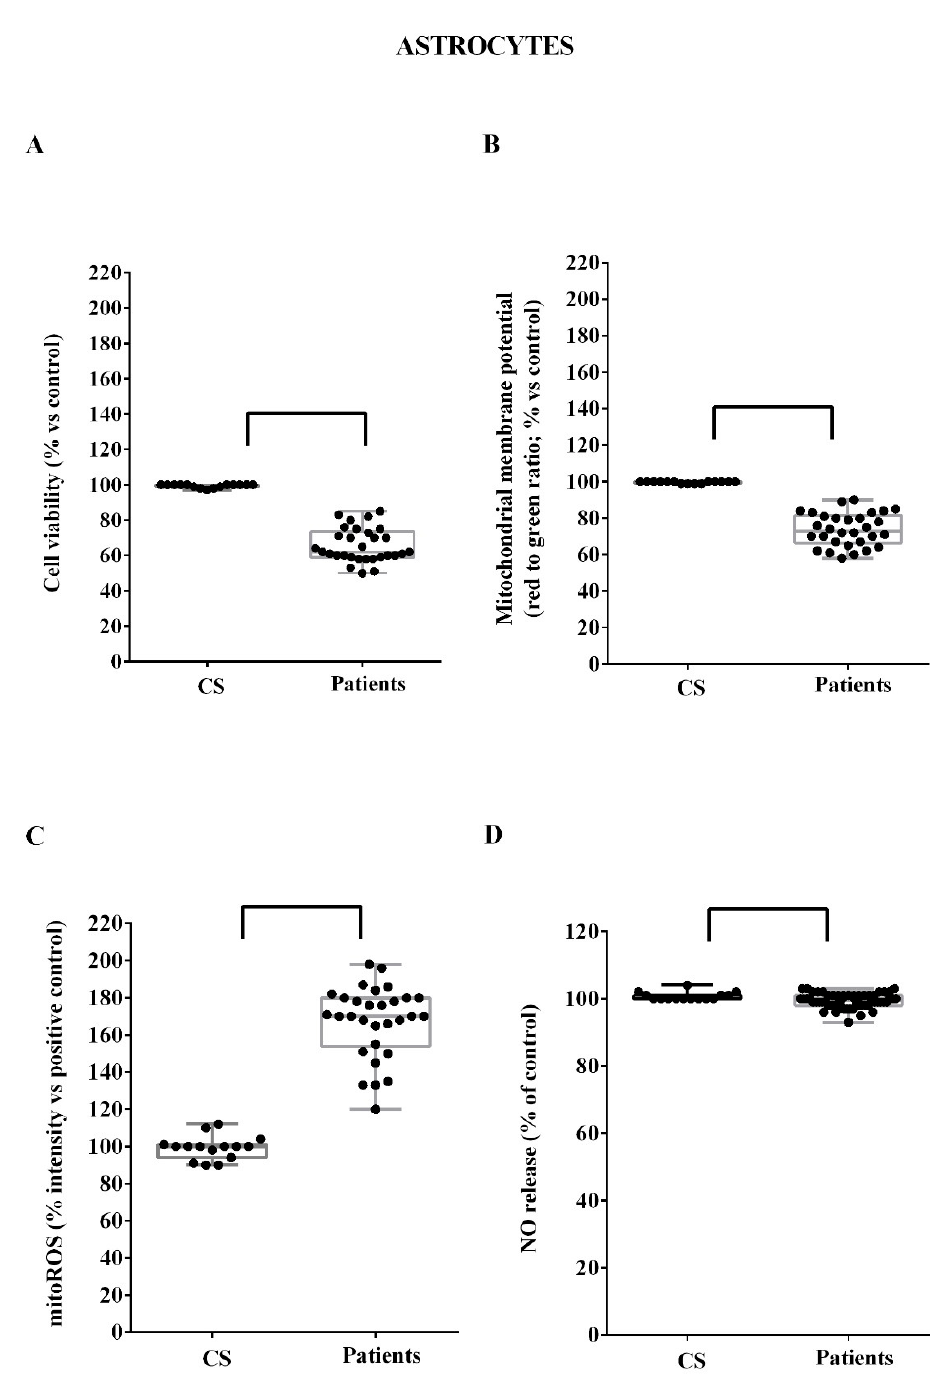
Figure 4. Effects of ALS plasma on cell viability ( A ), mitochondrial membrane potential ( B ), mitochondrial reactive oxygen species (mitoROS, ( C )) release and nitric oxide (NO) release ( D ), in astrocytes. CS: control samples. Square brackets indicate significance between groups as p < 0.05.